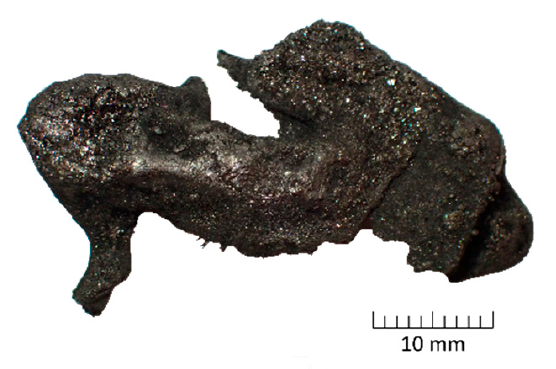
Figure 12. Metal fraction from the LCO-C experiment in Design 2. The transfer coefficients, which are illustrated in Figure 13, were determined from the results in Table 5, taking into account the corresponding weight changes of the individual fractions during the